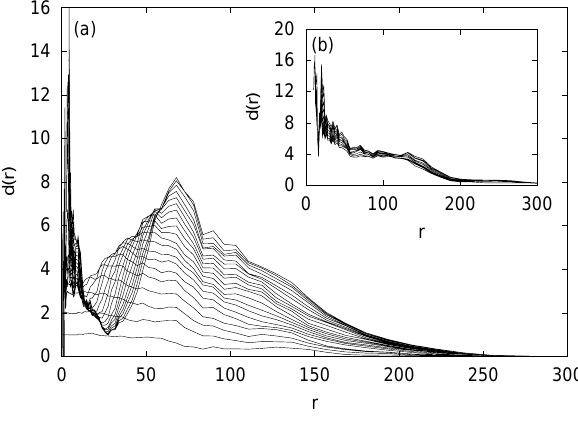
Fig. 8. (a) Plot of the local slopes of the logarithm of the corre- lation sums of the phase randomized time series of H for m = 1 , 2 ,..., 20 , τ = 10 and ω = 100 . (b) The same for the original times series of H for m = 12 , 13 ,..., 20 , τ = 10 and ω = 100